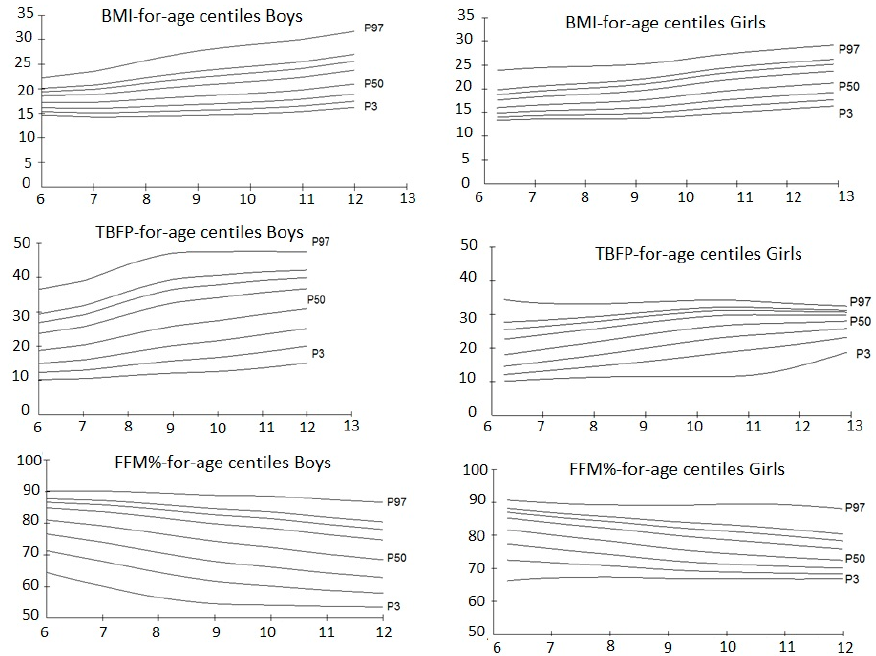
Figure 1. Percentile curves of the 3rd (P3), 10th, 25th, 50th (P50), 75th, 85th, 90th, and 97th (P97) for body mass index (BMI), total body fat percentage (TBFP), and free fat mass percentage (FFM%) by age and gender.